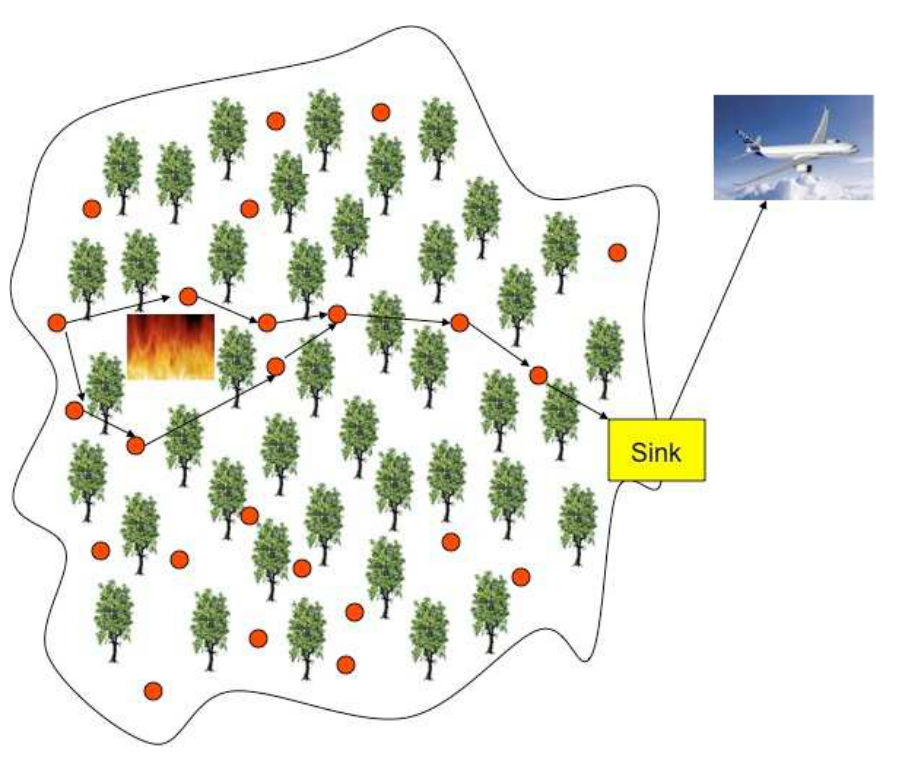
Figure 2. Event detection